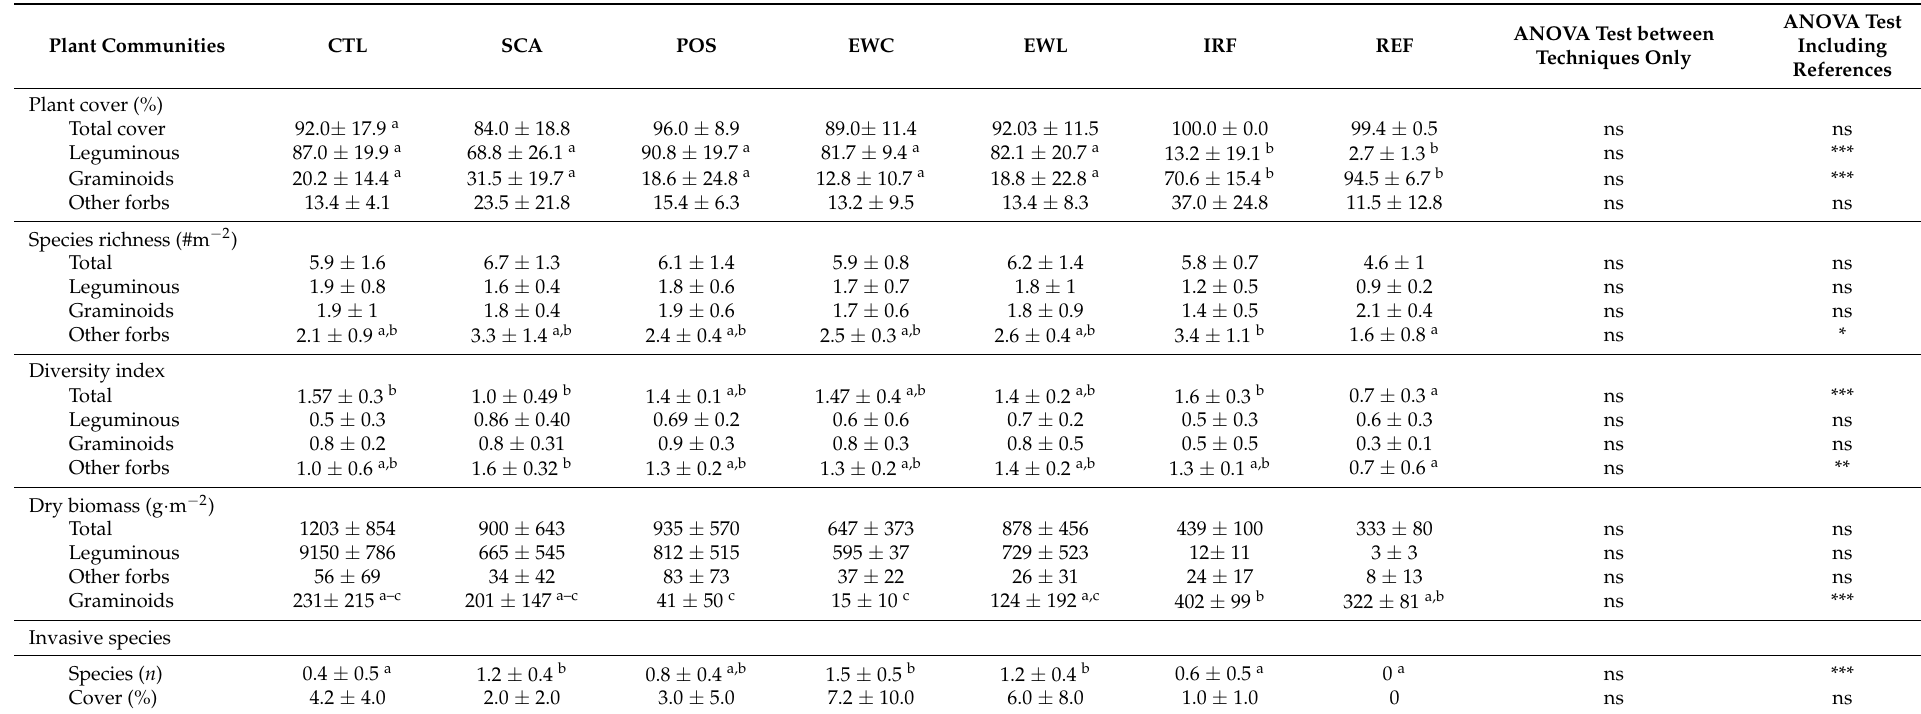
Table 1. Effect of restoration techniques on vegetation community characteristics (mean ± standard deviation, n = 5). Different letters indicate significant differences between treatments according to one-factor ANOVA tests and multiple comparison tests. See the Section 2 for soil restoration technique abbreviations. * p ≤